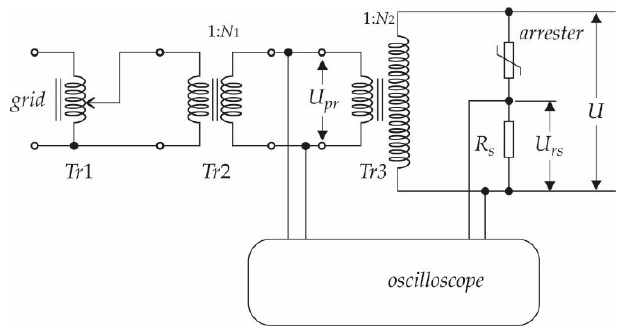
Figure 2. Measurement set-up scheme.